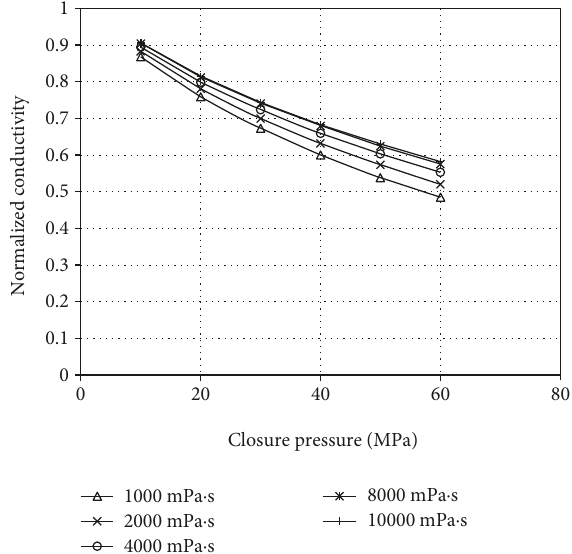
Figure 5: E ff ect of closure pressure on conductivity at di ff erent rock